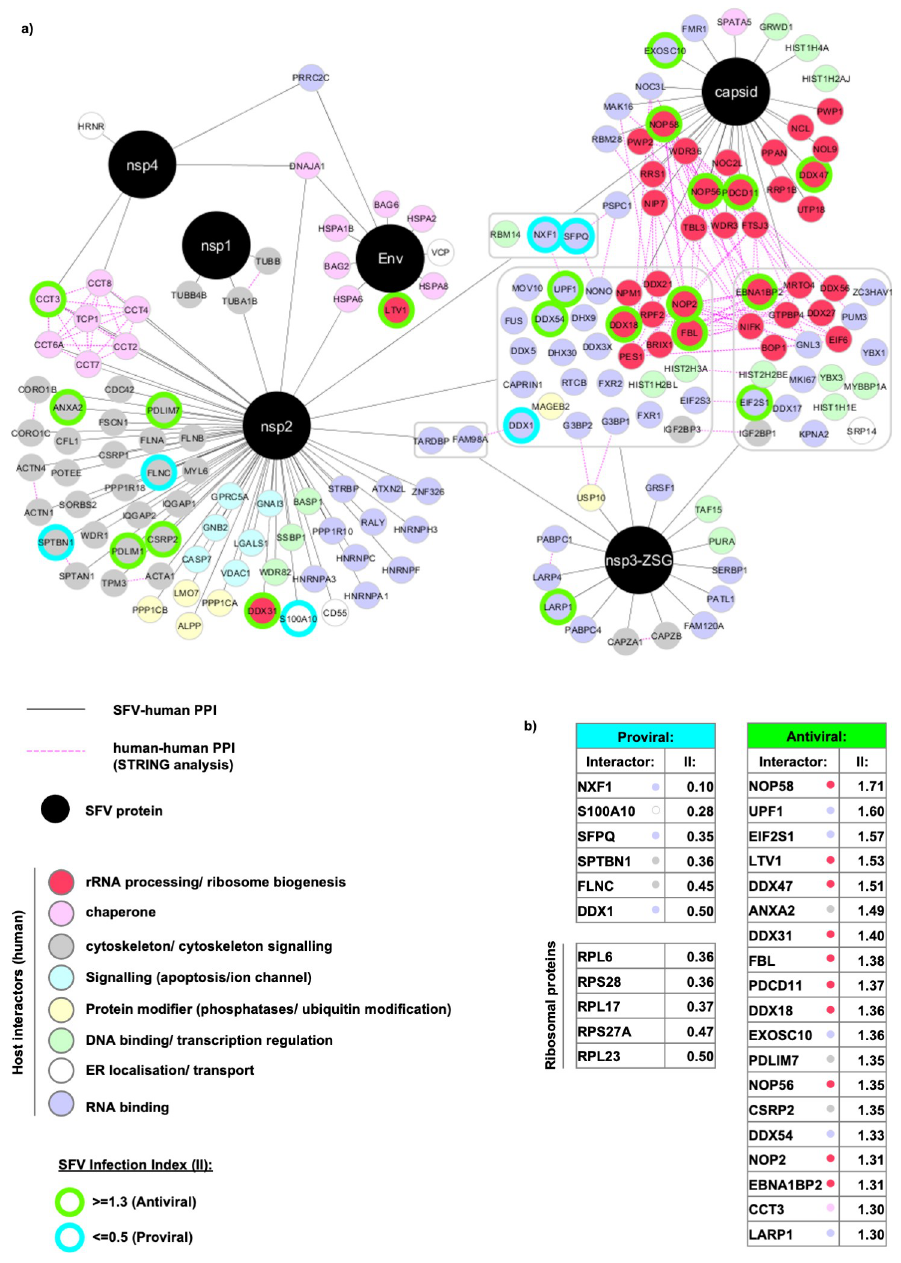
Fig 3. Network visualisation of the SFV-host protein interactome. a, In total, 174 host proteins are displayed. SFV proteins are depicted in black circles and host proteins are displayed in smaller colour-coded circles according to the key. SFV-host protein-protein interactions (PPI) are depicted with solid grey lines. Grey boxes reflect host proteins identified as interactors to more than one SFV protein. In these cases, the solid grey lines connect the grouped set of host proteins to the SFV proteins for which they were identified as interactors. Host-host PPI ascertained through STRING analysis are depicted with dashed pink lines. The host interactors were collected based on three independent biological replicates. For simplicity, ribosomal proteins (77) are shown separately in S3 Fig. SFV-host protein interactors identified through a genome-wide fluorescence microscopy based siRNA screen as exhibiting potential roles in SFV replication are additionally depicted by green and turquoise borders. A protein was defined as having a potential antiviral or proviral role if their Infection Index (II) values were � 1.3 or � 0.5, respectively. b, Tables showing the II values of SFV-host interactors with potential proviral or antiviral